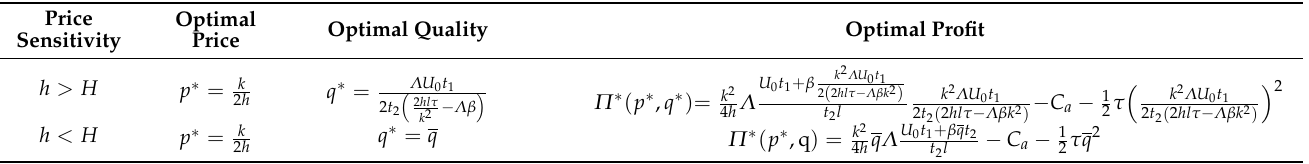
Table 2. Price-based advertiser